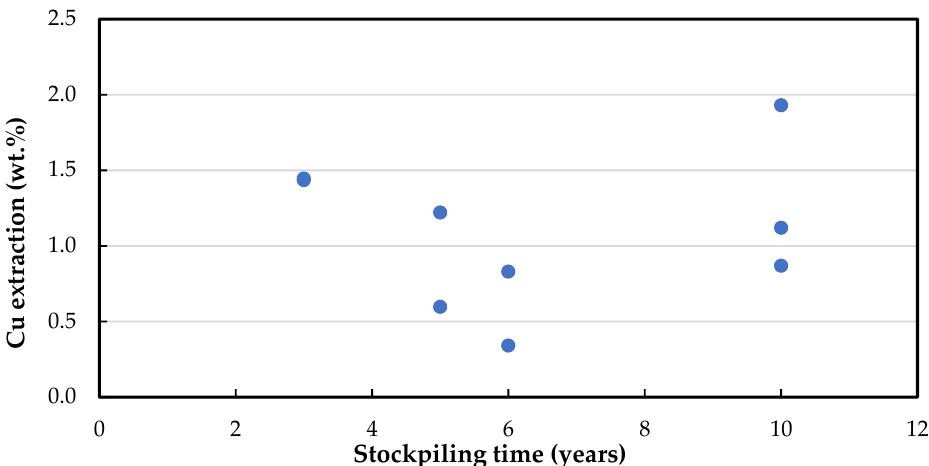
Figure 9. Backscattered electron images of sample 10Y-GRB-1  0, showing chalcopyrite particles that are partially altered to Cu oxides, Cu-Fe oxide, Cu-Fe hydroxides, Cu-Fe oxides.